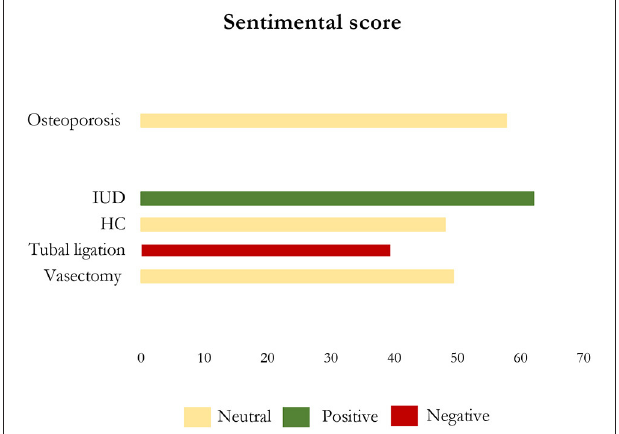
FIGURE 3 | Sentimental score comparisons between pre-menopause and post-menopause treatments. IUD, intrauterine device; HC, hormonal contraception. Sentiment analysis is classifying the polarity of the tweet—whether the expressed idea has positive, negative, or neutral